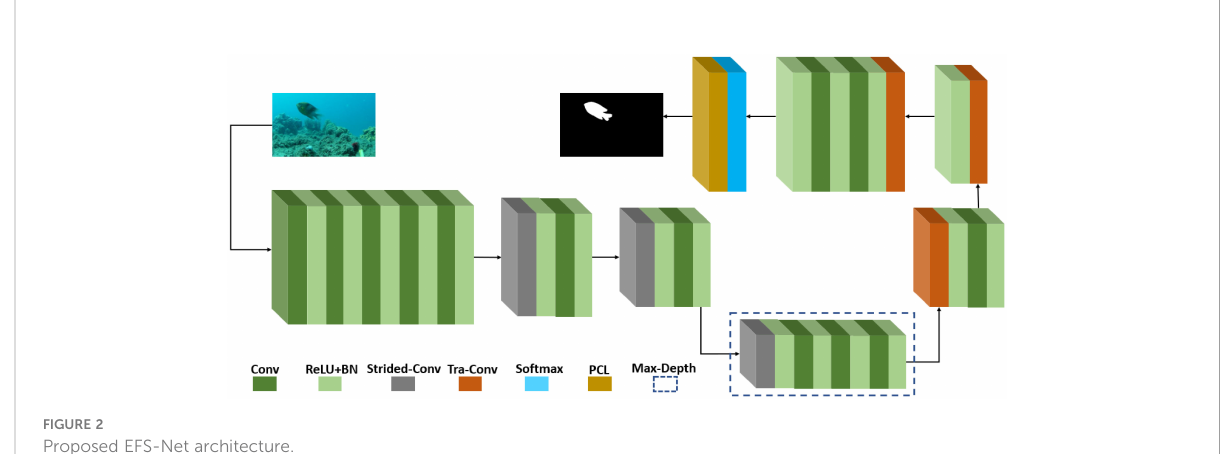
FIGURE 2 Proposed EFS-Net